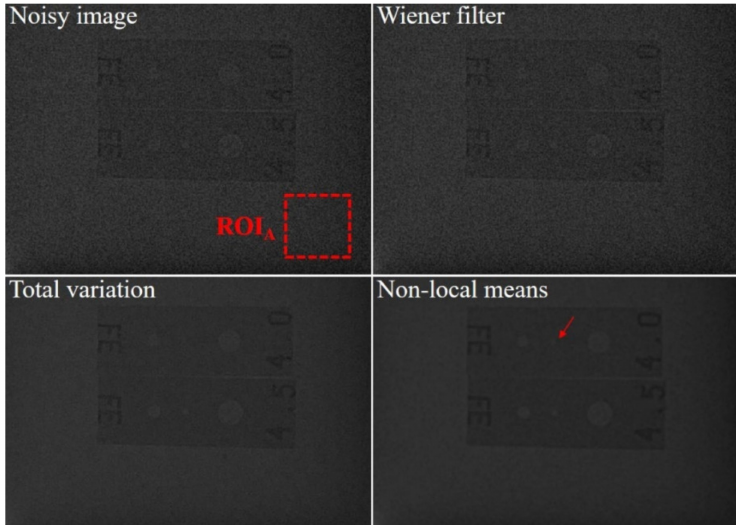
Figure 9. Images of the 50 mm Pb plate phantom with IQI penetrameters: noisy, Wiener filter, total variation, and proposed non-local means denoising algorithm. The images were acquired with our established industrial high-energy X-ray imaging system. The normalized noise power spectrum was calculated for the specified ROI A . Sensors 2020 , 20 , x